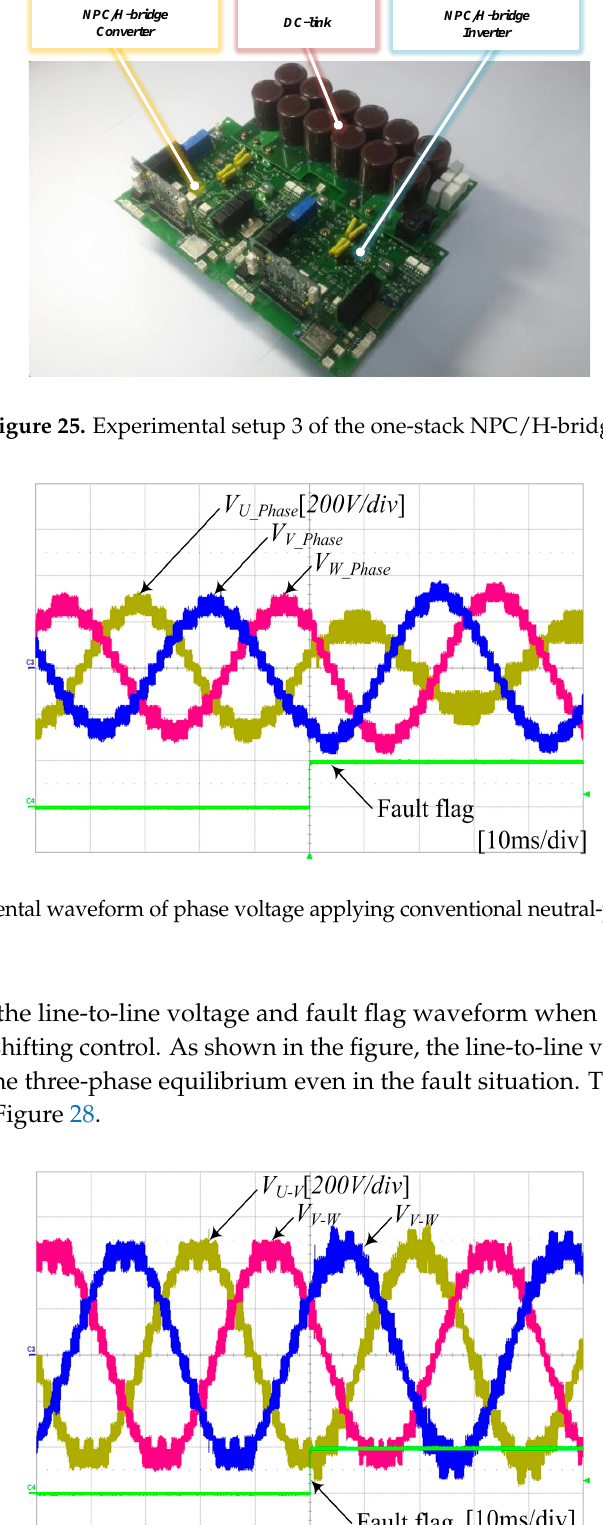
Figure 24. Experimental setup 2 of the 13-level cascaded NPC/H-bridge system